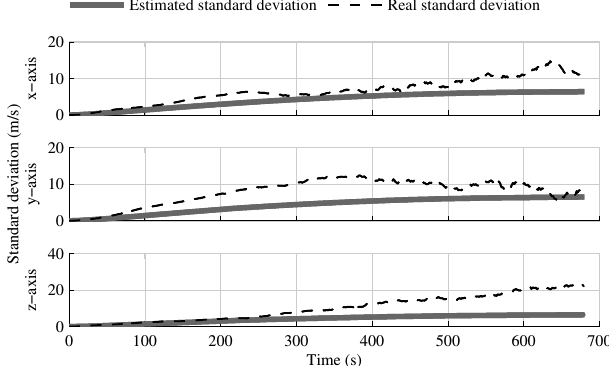
Figure 13. The velocity estimation error standard deviation computed by the navigation filter and the one obtained from Monte Carlo simulation, when the GPS receiver is not